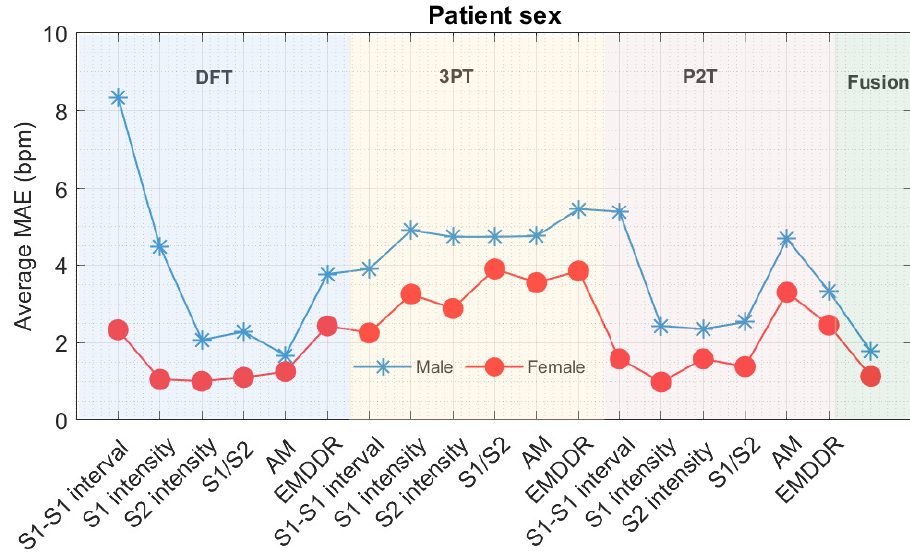
Figure 10. Comparison of MAE for male and female subjects.